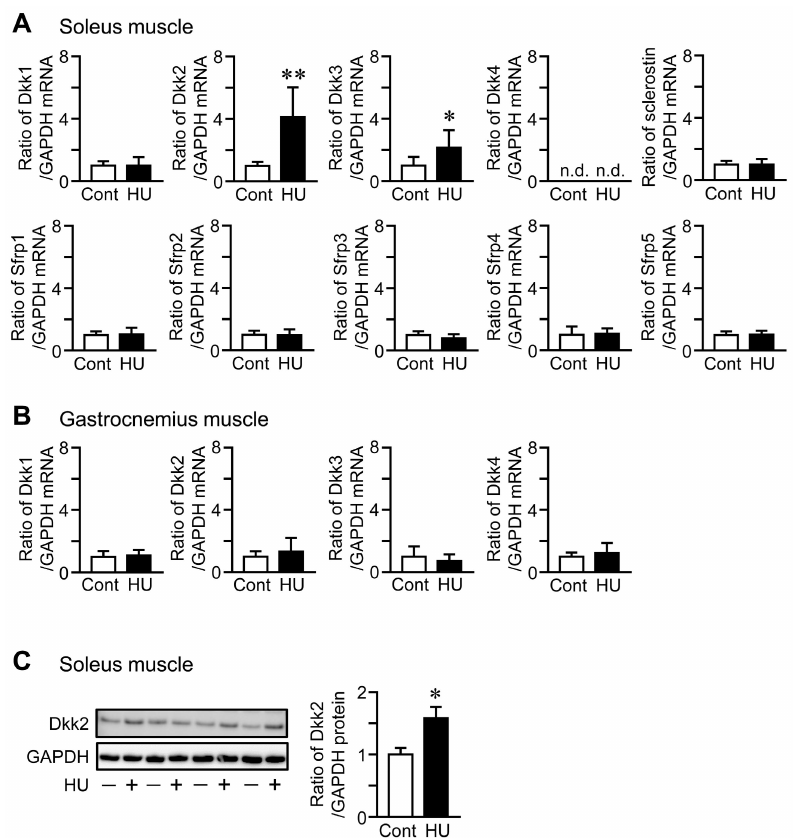
Figure 1. E ff ects of hindlimb unloading (HU) on the levels of canonical wingless-related integration site (Wnt) / β -catenin signaling-related factors in the skeletal muscle of mice. ( A , B ) Total RNA was extracted from the soleus ( A ) and gastrocnemius ( B ) muscles of control (Cont) mice and mice after HU for 3 weeks ( n = 8 mice in each group). Then, real-time polymerase chain reaction (PCR) analysis of Dkk1, Dkk2, Dkk3, Dkk4, sclerostin, Sfrp1, Sfrp2, Sfrp3, Sfrp4, Sfrp5 or glyceraldehyde-3-phosphate dehydrogenase (GAPDH) was performed. Data represent the mean ± standard deviation (SD) of eight mice in each group. ( C ) Total protein was extracted from the soleus muscle of control mice ( − ) or mice after HU ( + ) for 3 weeks ( n = 4 mice in each group). Then, Western blot analysis for Dkk2 or GAPDH was performed. The images represent experiments performed independently three times. Protein signals were quantified by densitometry and adjusted by the density of GAPDH. Data represent the mean ± SD of four mice in each group. ** p < 0.01, * p < 0.05 vs. control group (Mann-Whitney U